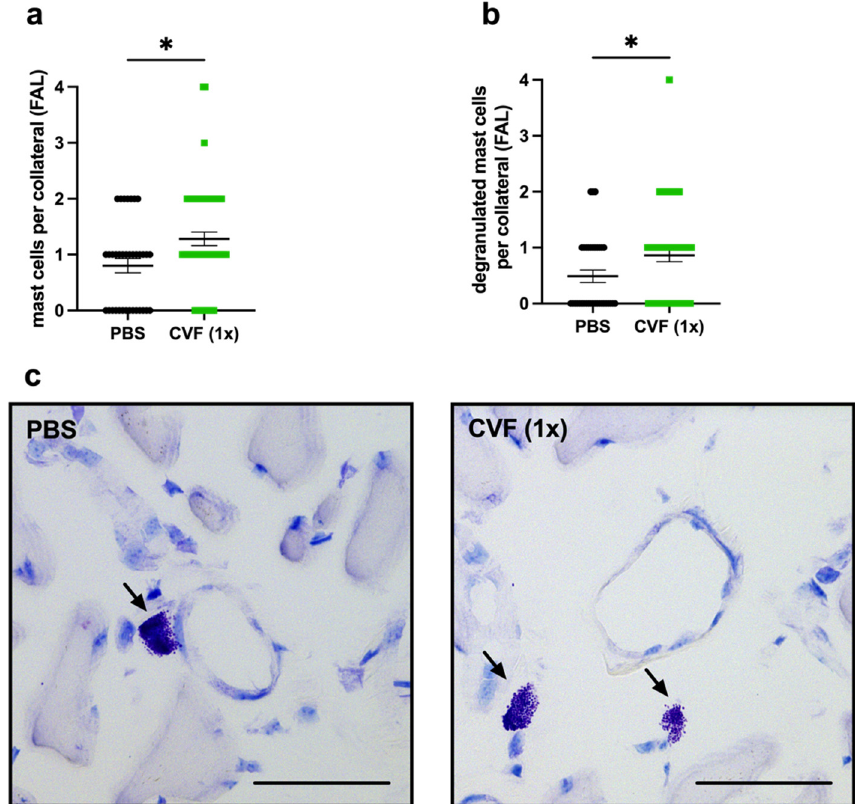
Figure 5. Single-dose application of the cobra venom factor (CVF 1x)) increases the number of perivascular mast cells and promotes the degranulation of mast cells around growing collateral arteries. The scatter plots represent ( a ) the number of perivascular mast cells per collateral in the adductor muscles 8 h after femoral artery ligation (FAL) of phosphate-buffered saline (PBS)- and CVF-treated mice, as well as ( b ) the number of degranulated mast cells per collateral 8 h after FAL. Data are the means ± S.E.M., n = 3 mice per group, n > 10 values per group, * p < 0.05 (PBS vs. CVF (1x)) by the unpaired Student’s t -test. ( c ) Representative Giemsa stains depicting mast cells (arrows) in the perivascular space of collateral vessels of PBS- (left image) and CVF (1x)-treated (right image) mice 8 h after FAL. Scale bar: 50 µm.